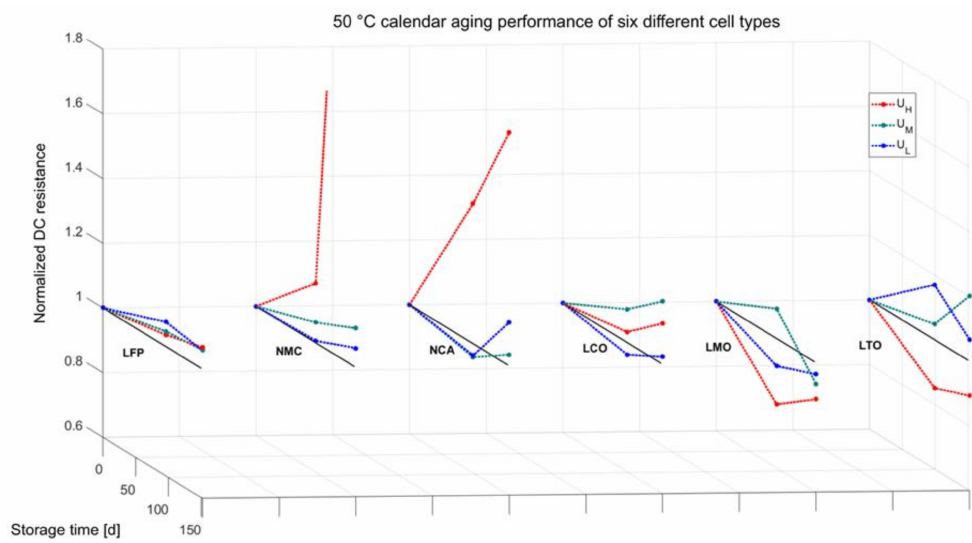
Figure 7. Normalized DC resistance increase of six chemistries at 50 ◦ C storage over 150 days at three storage voltages (U L -voltage low, U M -voltage mid, U H -voltage high), every plot point resembles the average of all measurements at that same condition, current pulse for measurement for all cells at U M , with NMC cells dead at the last checkup.